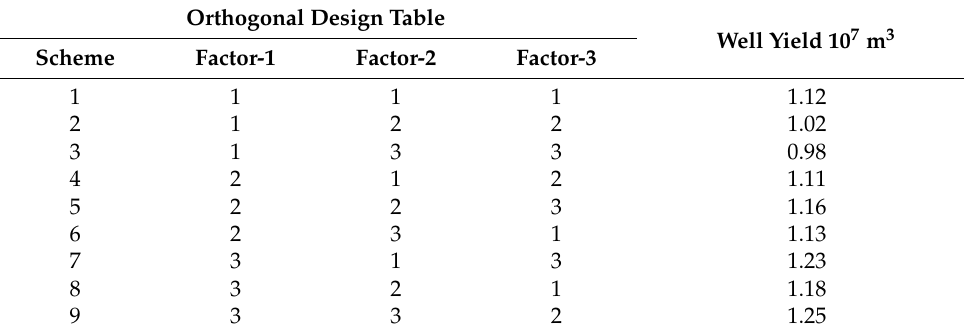
Table 8. Orthogonal design table for vertical wells. Table 9 is the yield analysis table of the different schemes of deviated wells. Table 9. Yield analysis table for different schemes of vertical wells. Orthogonal Design